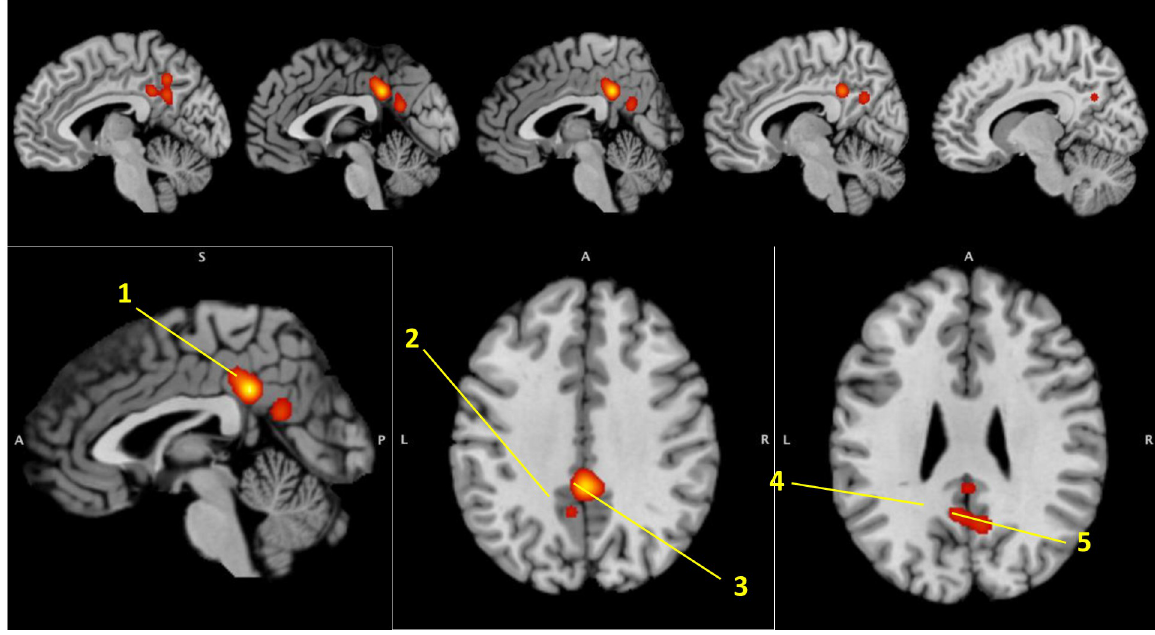
Fig 2. Regions identified by corrected ALE. Note: 1 = Cingulate Gyrus; 2 = Precuneus; 3 = Cingulate Gyrus/Precuneus; 4 = Posterior Cingulate/ Precuneus; 5 = Posterior